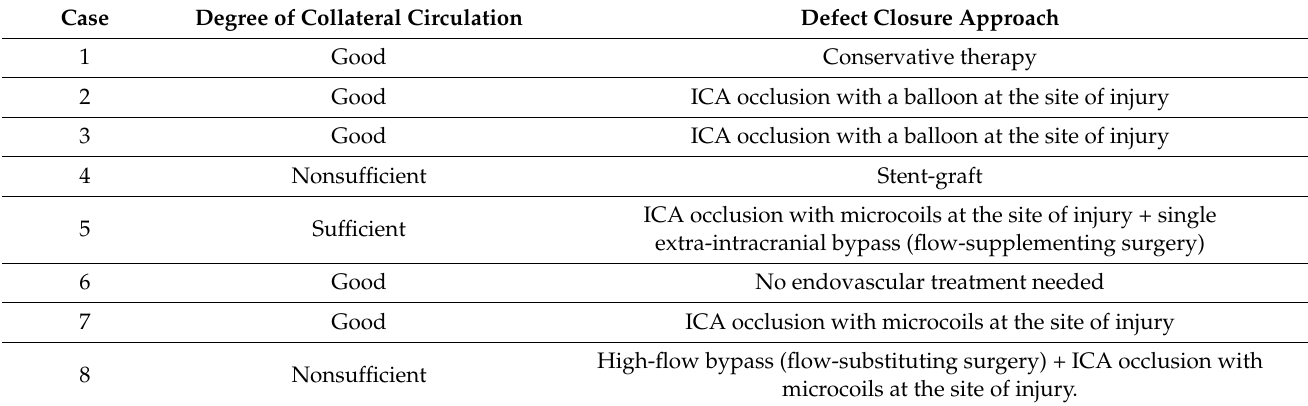
Table 2. ICA defect closure approach depending on the degree of collateral